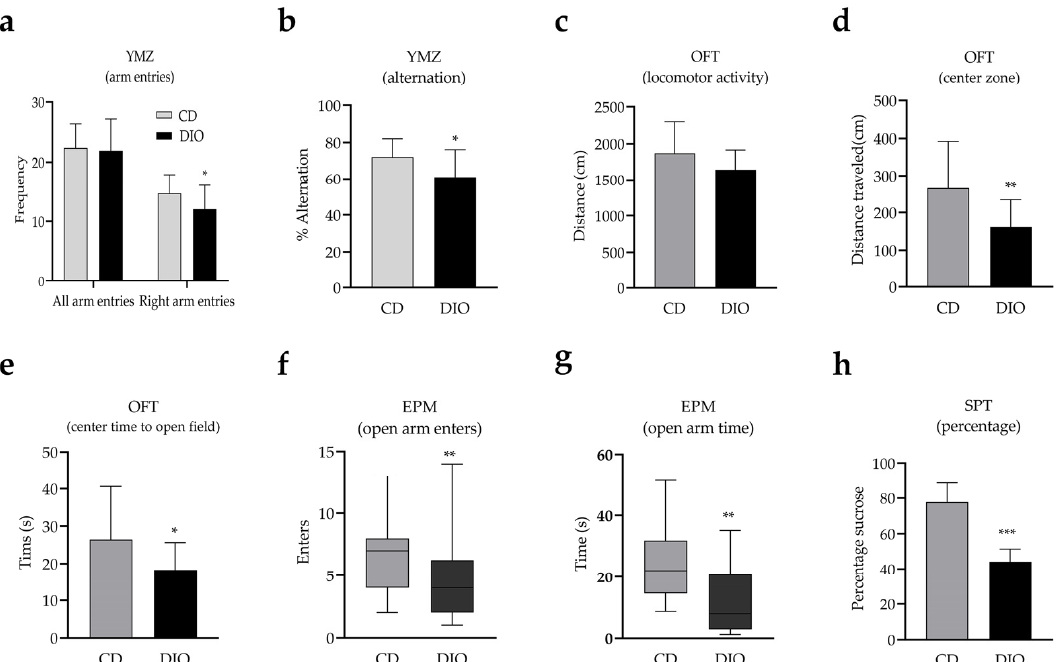
Figure 5. Diet-induced obesity (DIO) mice show impaired short-term spatial working memory, anxiety-like, and anhedonic behaviors. Arm entries ( a ) and alteration ( b ) in elevated plus maze (YMZ), locomotor activity ( c ) in open field test (OFT), center distance traveled ( d ) and time ( e ) in OFT, number of entries ( f ) and time spent ( g ) in open arms of elevated plus maze (EMP), sucrose preference percentage (SPT) ( h ). * p < 0.05, ** p < 0.01, *** p < 0.001. When compared with the CD group, results were presented as the mean ± SD or median (quartile spacing).